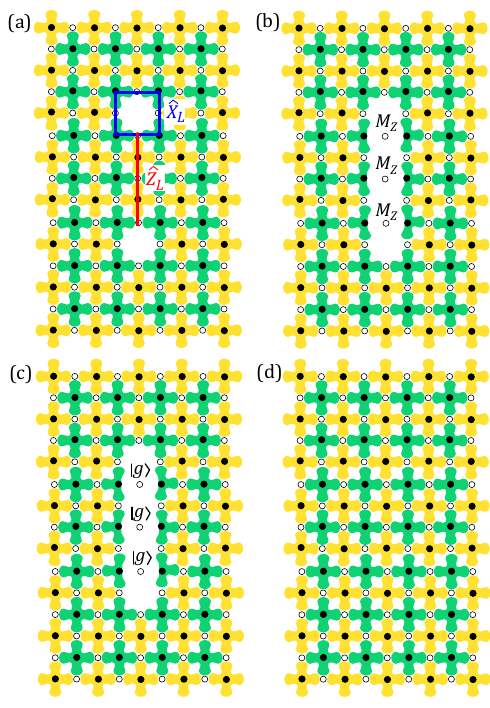
Figure 32: A Z -axis (“difficult”) measurement process for an X-cut logical qubit. (a) Start- ing with an X-cut qubit, (b) turn off the measure-X qubits between the two qubit cuts while also switching the neighboring measure-Z qubits from four- to three-terminal